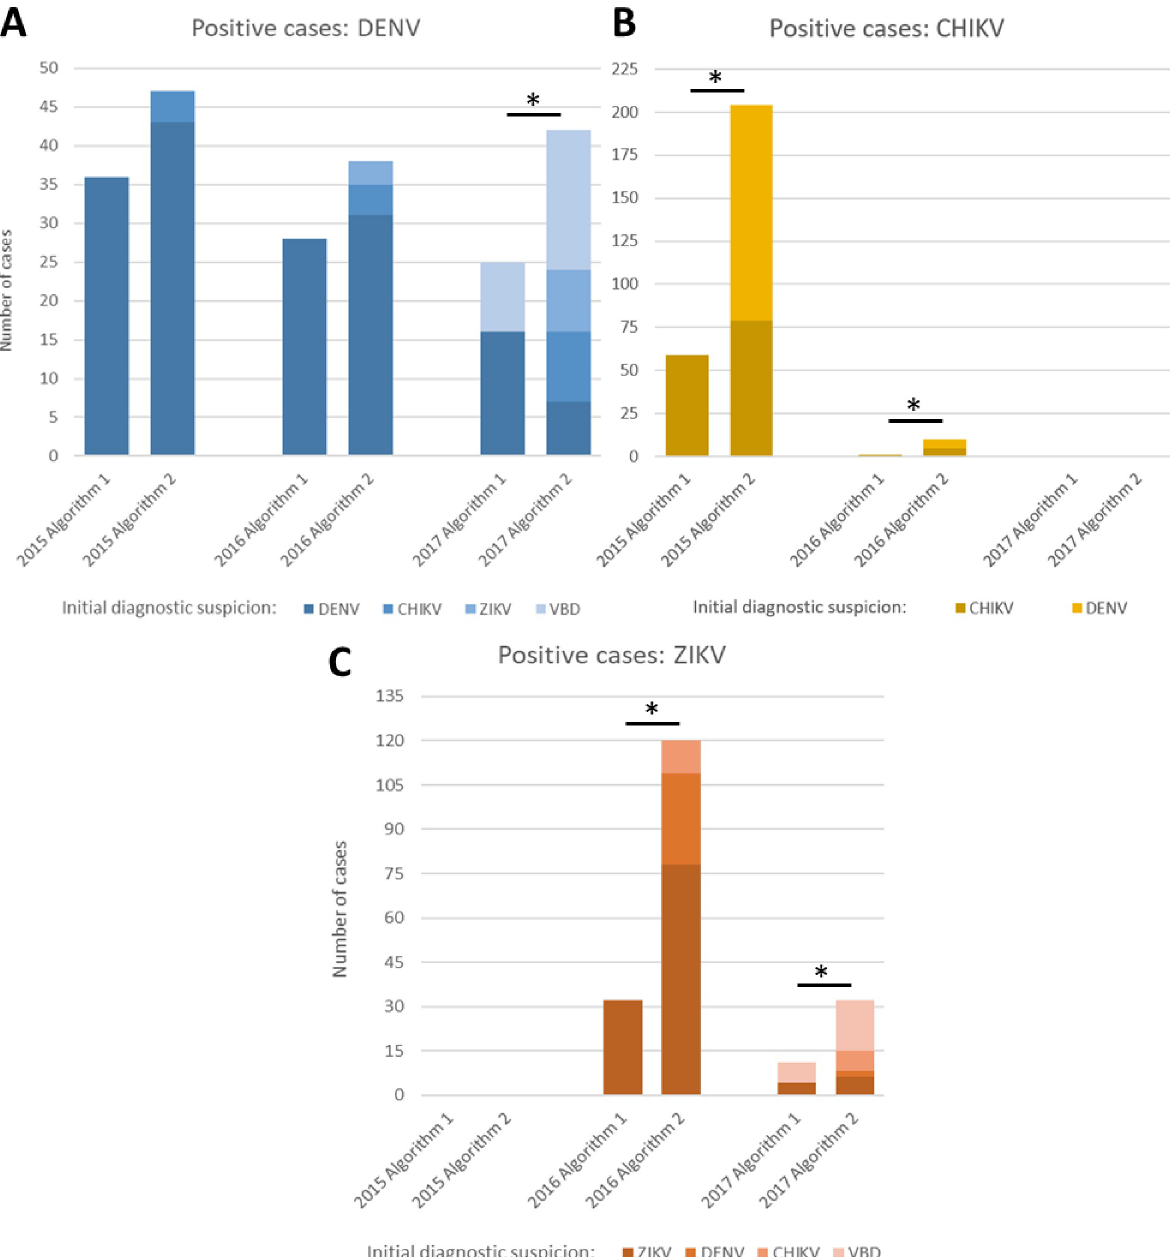
Fig 1. Positive cases for each Virus/Year/Algorithm. The graphs show the positivity for each virus: (A) DENV. (B) CHIKV. (C) ZIKV. Algorithm 1: Uniplex RT-qPCR reactions for each virus, with the restriction of performing only one reaction for each sample according to the initial diagnostic suspicion (details in S1 Fig). Algorithm 2: Multiplex RT-qPCR reaction that simultaneously detected the presence of the three viruses was performed on all samples, regardless of the initial diagnostic suspicion. � Significant differences (P < 0.05) between the proportion of positive cases detected with algorithms 1 and 2. Note: in the last quarter of 2017, when the multiplex algorithm was implemented for all cases suspected of some vector-borne disease (VBD), a third-party kit was used for the diagnosis, and only from the second half of 2018, the LCE started using the TaqMan Zika Virus Triplex Kit also used in the present